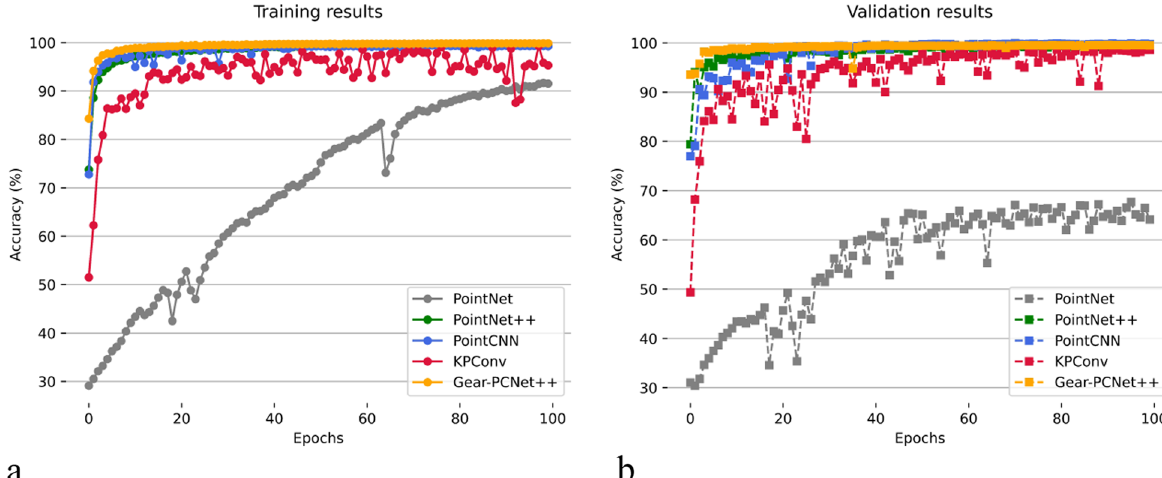
Fig. 11 Accuracy in training and validation. a Accuracy of training set; b Accuracy of validation set. In both a and b , a marker represents the accuracy of the network at the current epoch of training or validation. Specifically, gray represents PointNet, green represents PointNet represents PointCNN, red represents KPconv and yellow represents Gear-PCNet